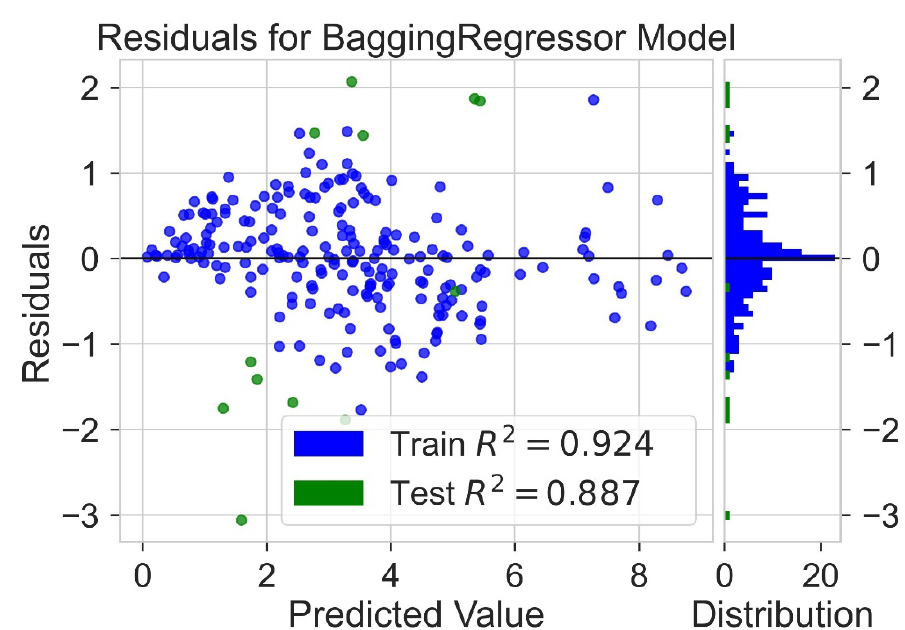
Figure 8. Residuals for bagging regressor model.